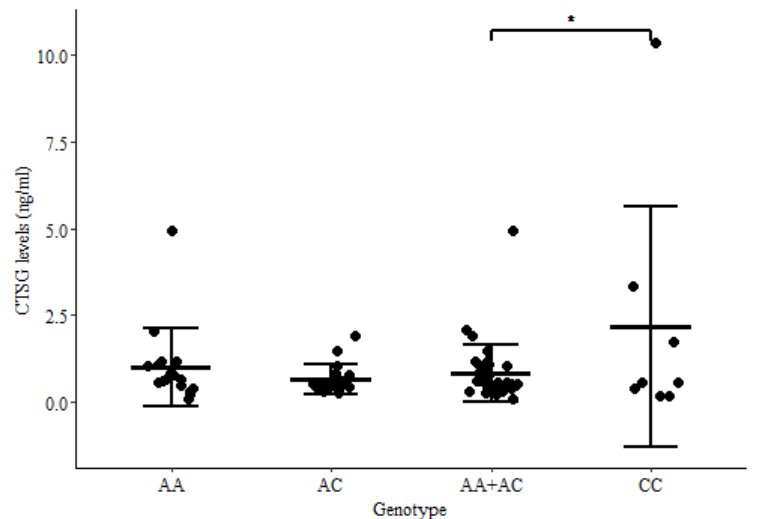
Figure 3. Plasma CTSG levels in carriers of different genotypes of cis-eQTL-rs41976219. CTSG levels measured in the plasmas of cows without lesions in gut tissues and with the AA, AC, and CC genotypes for cis-eQTL-rs41976219 by ELISA. Data are shown as the mean ± SD of 44 cattle, 8 carriers of the CC, 17 of the AA, and 19 of the AC genotypes. Statistically significant differences are observed in the mean CTSG levels in the plasmas of cows with the CC genotype when compared with cows with the AA + AC genotypes. p -values are calculated using an unpaired t -test. * p -value ≤ 0.05.